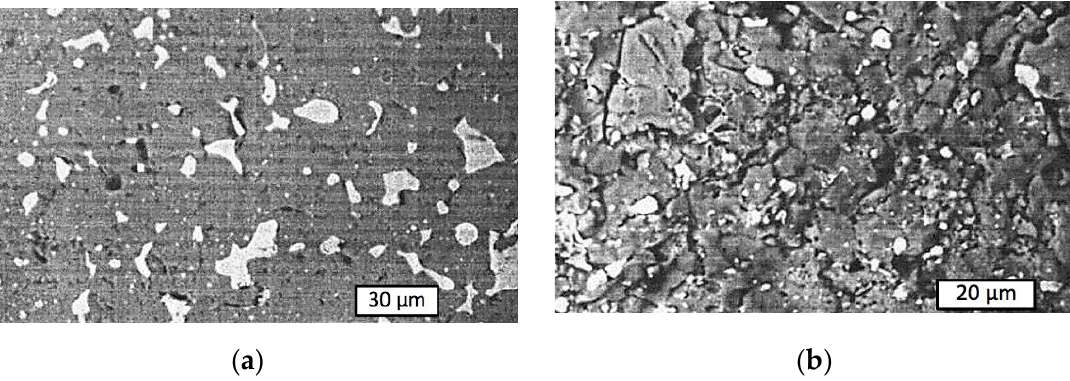
Figure 11. Cermet samples sintered from Cr 2 O 3 + 13 wt.% Al powder at Т = 1600 °С under Р = 30 MPA for t = 10 min: ( a ) microstructure; ( b ) fractogram.